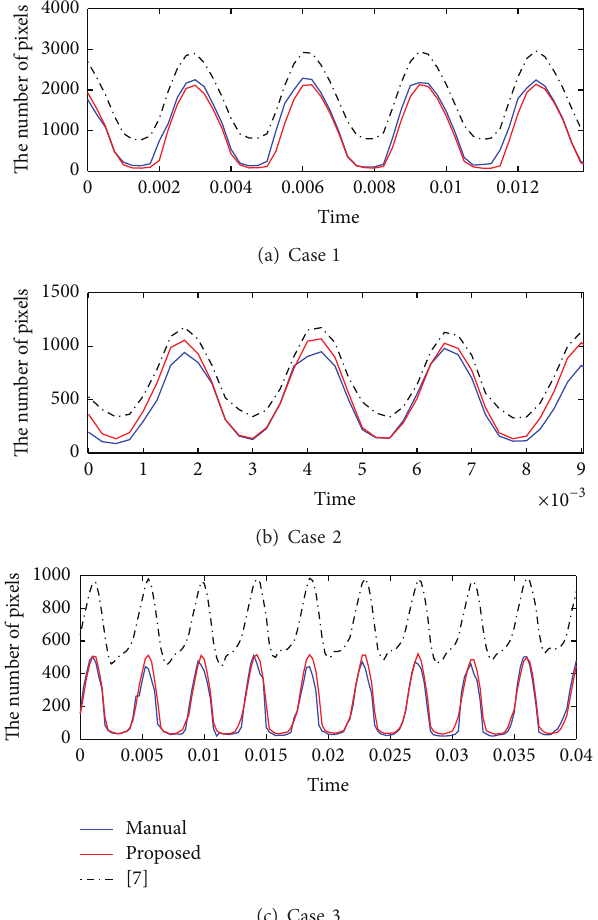
Figure 22: Manually extracted and automatically estimated glottal area signals Cases